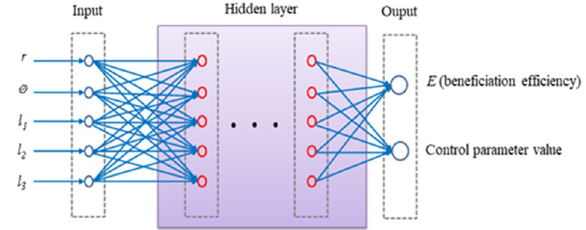
Figure 6. Simulation model of beneficiation shaking